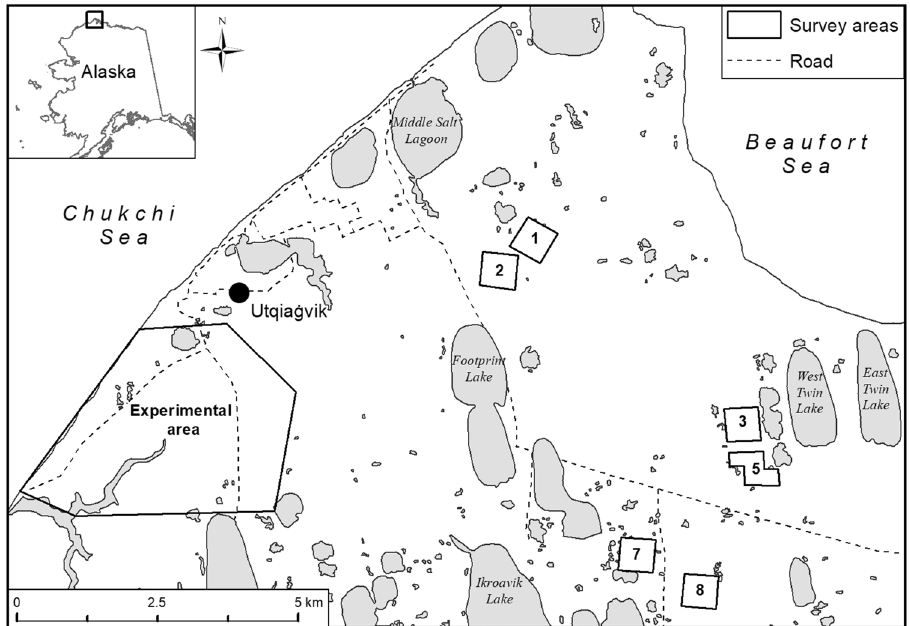
Figure 1. Location of unmanipulated (i.e., the six 36-ha numbered plots) and experimental study areas used to investigate Dunlin chick survival near Utqiaġvik, Alaska, 2008–2009. (Generated by ArcGIS 10.8.1, URL: http:// www. esri. com/ softw are/ arcgis/ arcgis- for- deskt